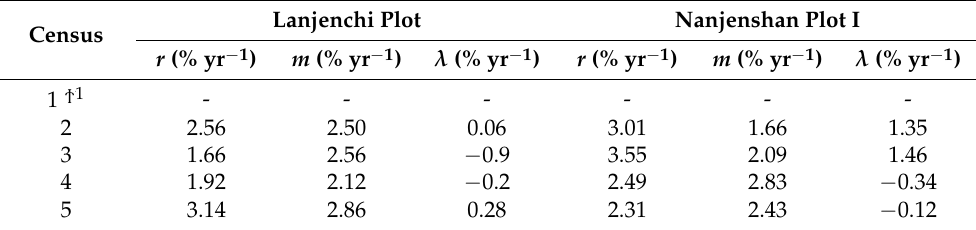
Table 1. Changes in forest structure of the 5.88-ha Lanjenchi plot and 2.1-ha Nanjenshan plot I . Table 2. Dynamic changes in the 5.88-ha Lanjenchi plot and 2.1-ha Nanjenshan plot I.